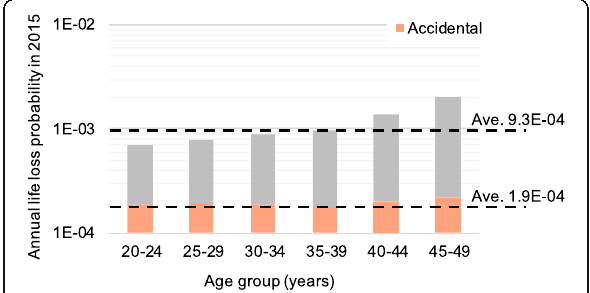
Fig. 6 Annual life loss probability per age group based on the Canadian population mortality rates 2015 (Statistics Canada 2018)